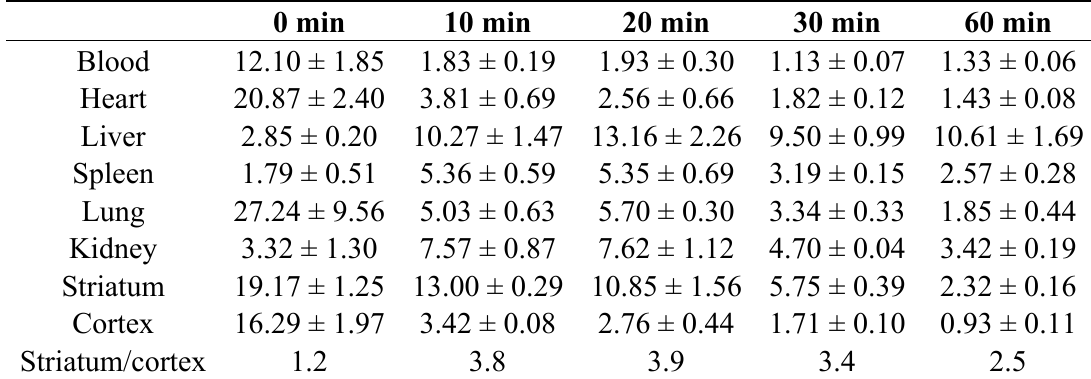
Table 2. Biodistribution of [ 11 C]-(+)-  -DTBZ in mice (mean ± SD, n = 5,